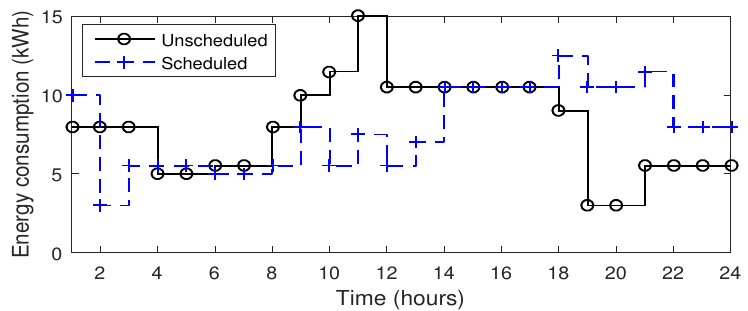
Figure 17. Daily energy consumption of r , el and iel